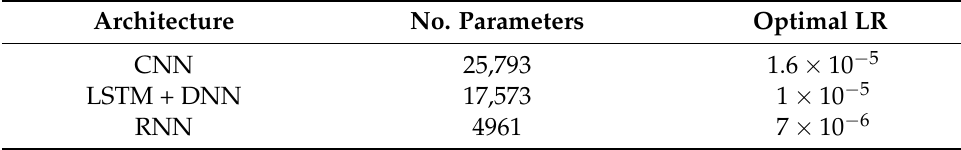
Table 1. Number of parameters and optimal learning rate for each architecture.